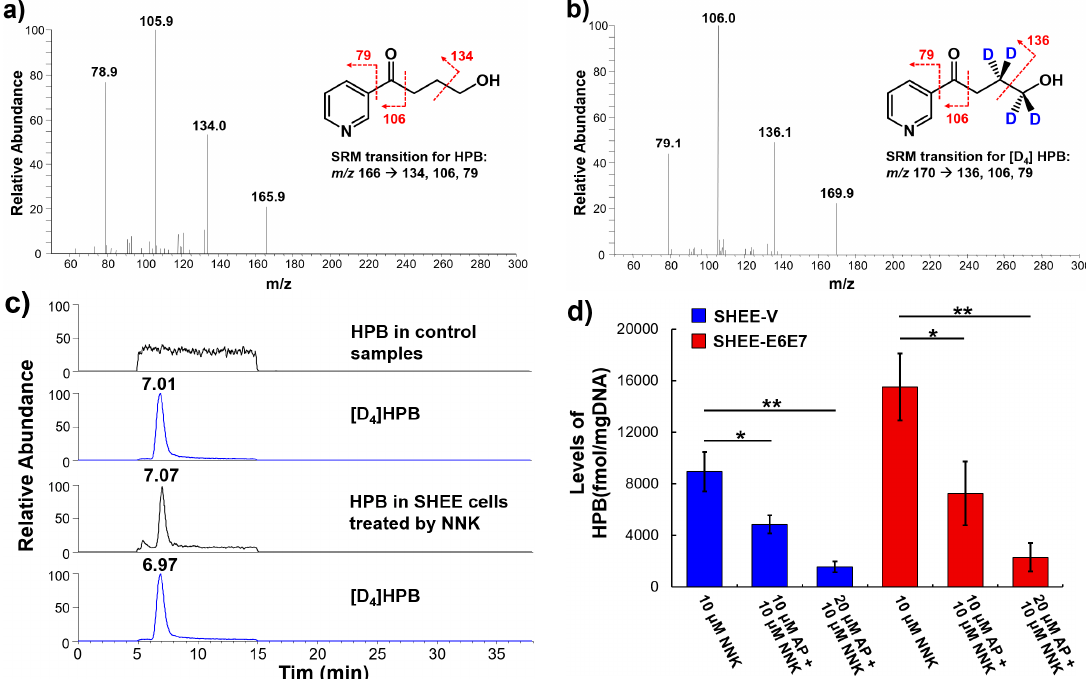
Figure 5. AP suppressed the levels of pyridyloxybutylated (POB)-DNA adducts induced by NNK in cooperation with HPV. ( a ) fragmentation of HPB and spectra of MS2 full scan; ( b ) fragmentation of the isotope-labeled [D 4 ]HPB and spectra of MS2 full scan; ( c ) representative selective reaction monitoring (SRM) chromatograph of the DNA samples from the control and NNK-treated groups; ( d ) determined levels of HPB in SHEE cells after 24-h NNK exposure with AP pretreatment. Data are presented as mean ± SD ( n = 3). * p < 0.05, ** p < 0.01.